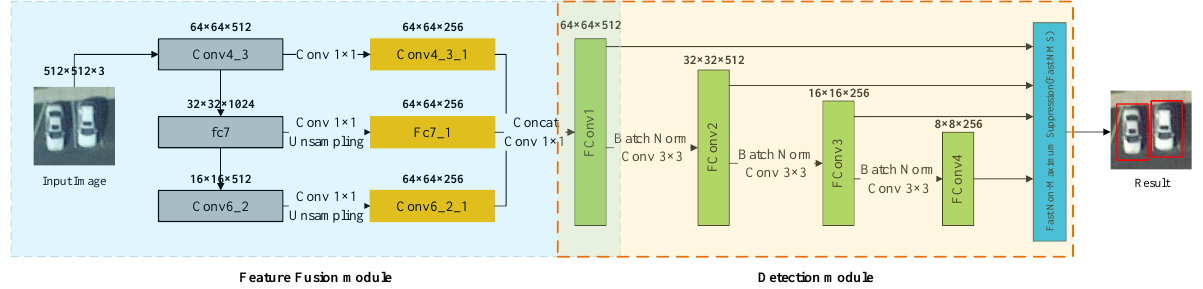
Figure 3. The structure of our network